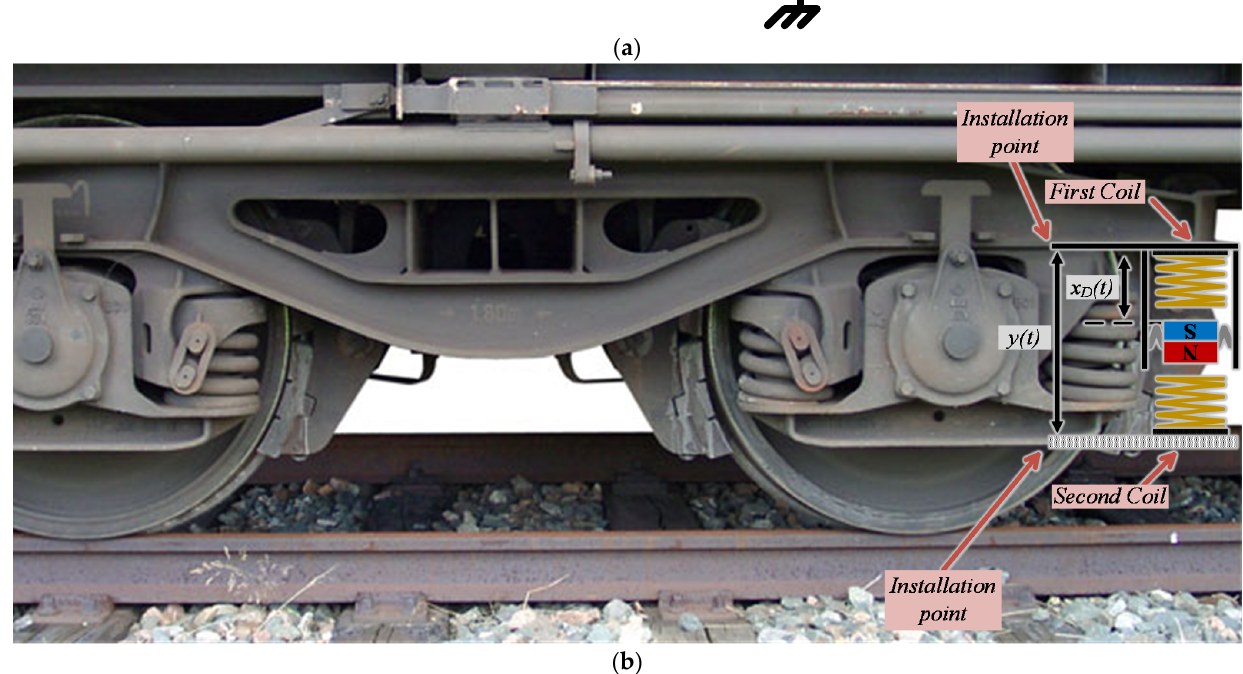
Figure 4. ( a ) Schematic representation of a double coil resonant electromagnetic vibration energy harvester. ( b ) Possible installation on a fright wagon.